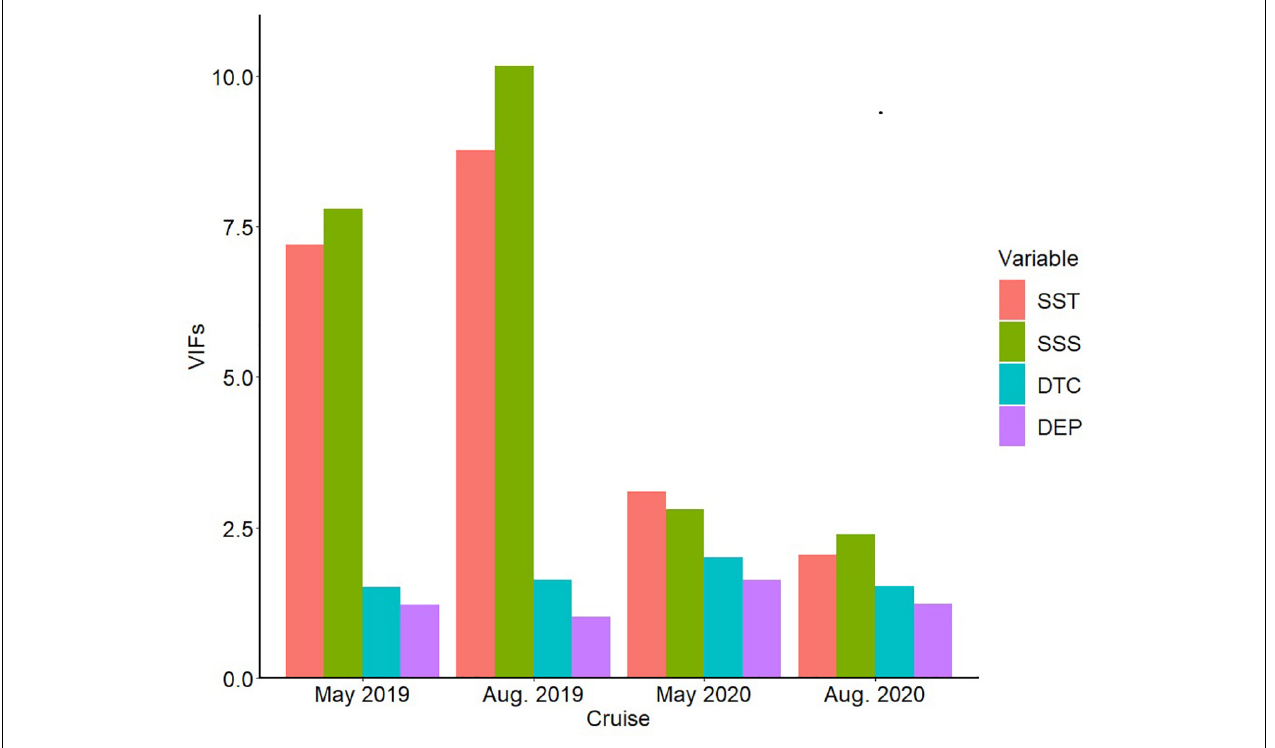
FIGURE 2 | Monthly variance inflation factor (VIFs) of all the selected abiotic variables in the Yangtze Estuary in 2019 and 2020.